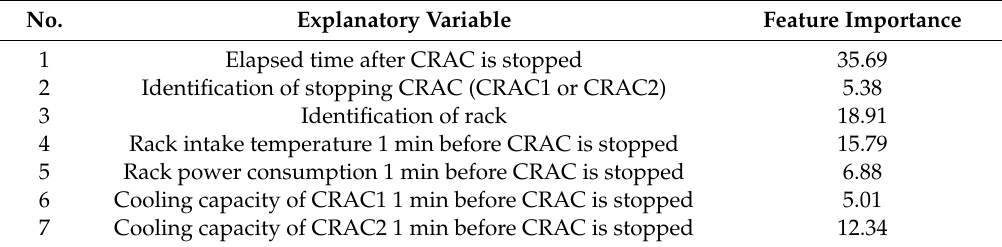
Table 14. Feature importance of each explanatory